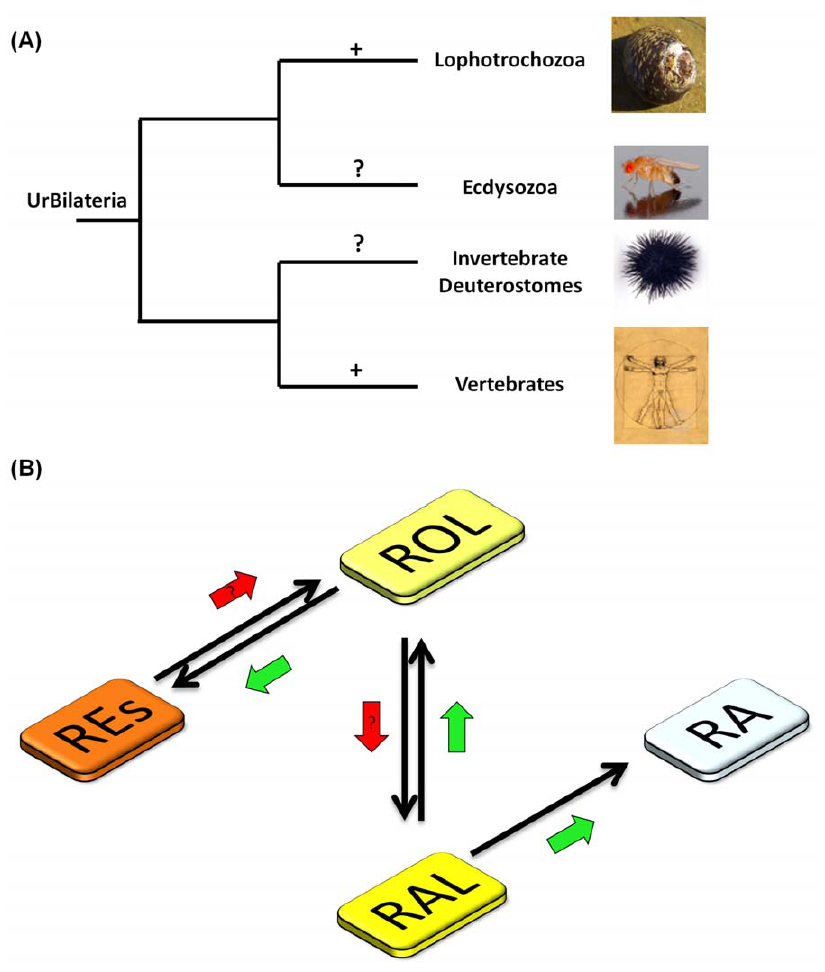
Figure 7. Distribution of retinyl ester storage capacity and canonical/molluskan retinoid pathways . (A) Phylogenetic distribution of the confirmed presence of retinyl ester storage capacity in different bilaterian groups. The inference of RE in Lophotrocozoa is derived from Osilinus lineatus . (B) Canonical metabolic pathways from retinyl esters (REs) to retinoic acid (RA). Black arrows indicate the metabolic transformations that are known to occur in amniotes. Green arrows indicate the steps that are functional in the mollusk Osilinus lineatus . The red arrow indicates the metabolic transformations that remain to be demonstrated in O. lineatus . (ROL) retinol; (RAL) retinaldehyde.